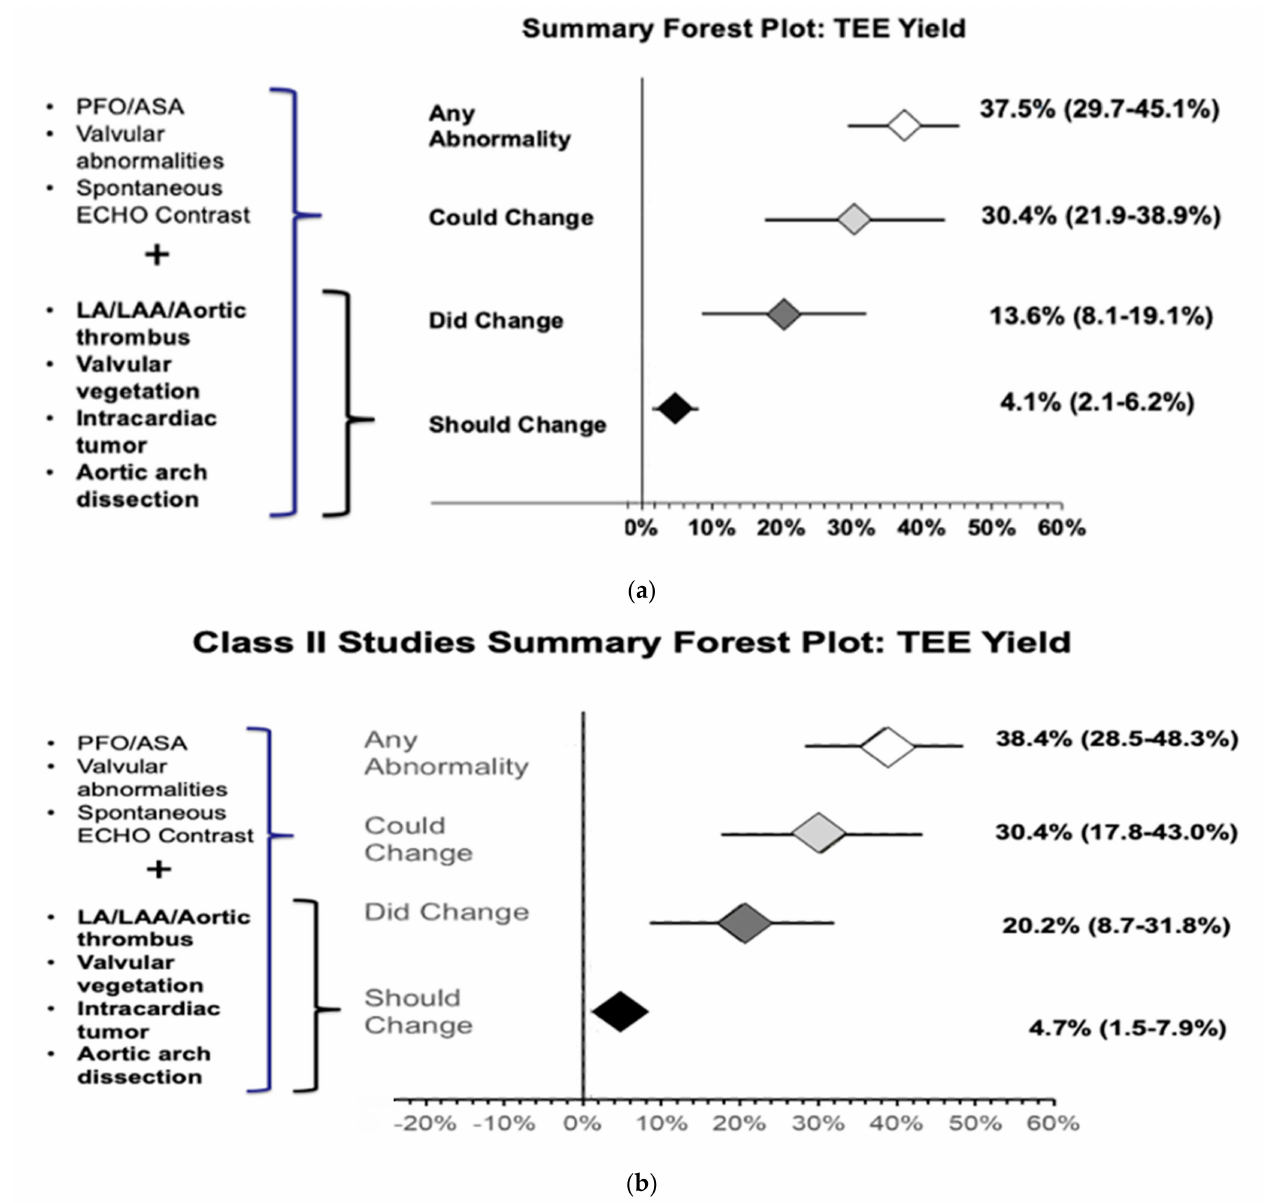
Figure 4. ( a ) Forest plot of additional cardiac abnormality on TEE evaluation and TEE findings that did change, should change, or could potentially change the management of CS/TIA patients after TEE evaluation. ( b ) Forest plot of additional cardiac abnormality on TEE evaluation and TEE findings that did change, should change, or could potentially change the management of CS/TIA patients after TEE evaluation in class II